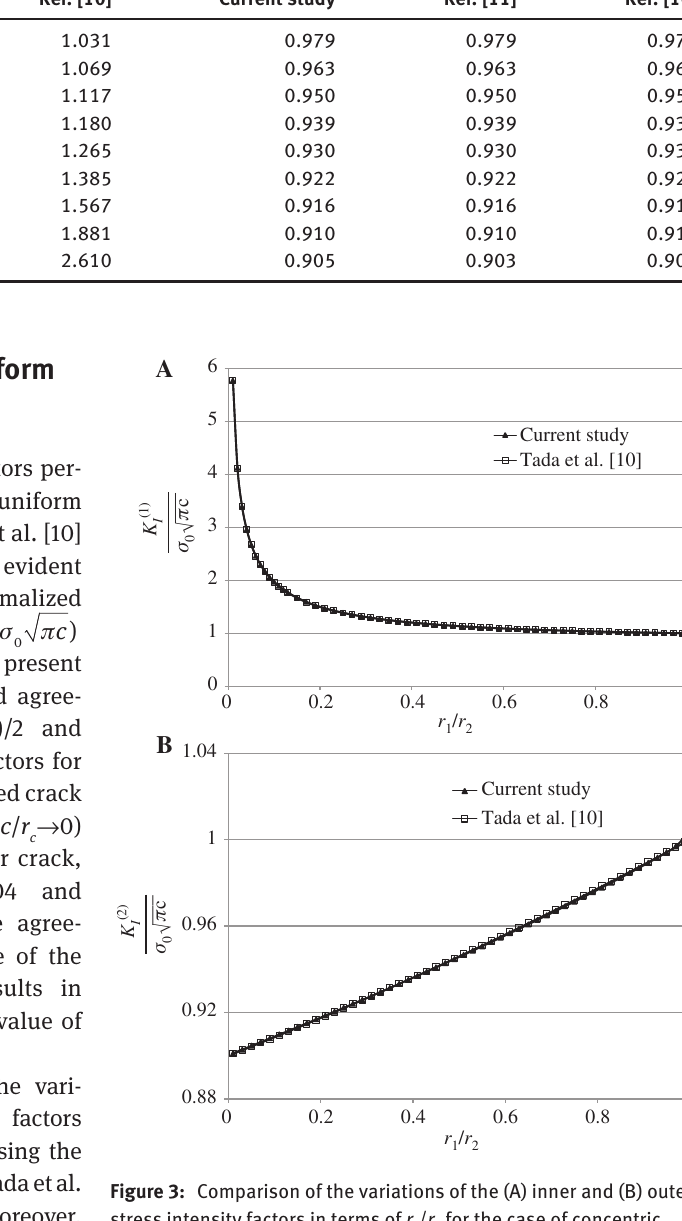
/ r for the case of concentric 1 2